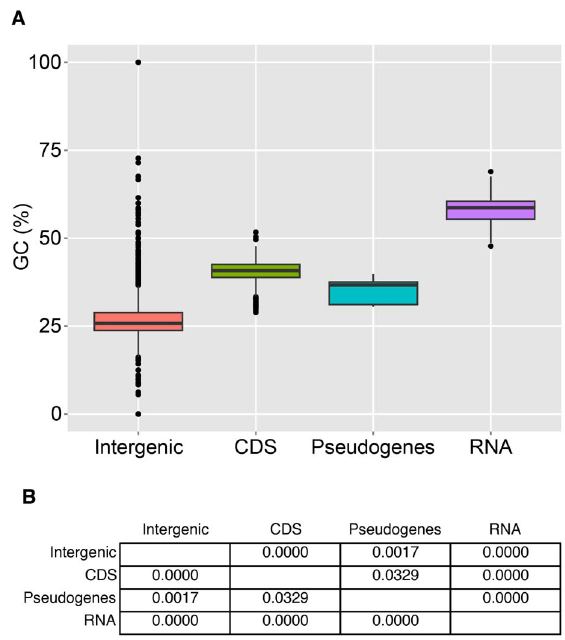
Figure 8. The Ca. E. faulkneri genome is made up of regions with different GC content. The GC content of discrete regions (for example, all coding sequences) from the genomes of both Ca. E. faulkneri strains were tabulated and used to create the boxplot shown in (A). The groups were determined to be different from one another by ANOVA followed by Tukey HSD (see Materials and Methods). The individual p values for the pairwise comparisons are shown in (B).